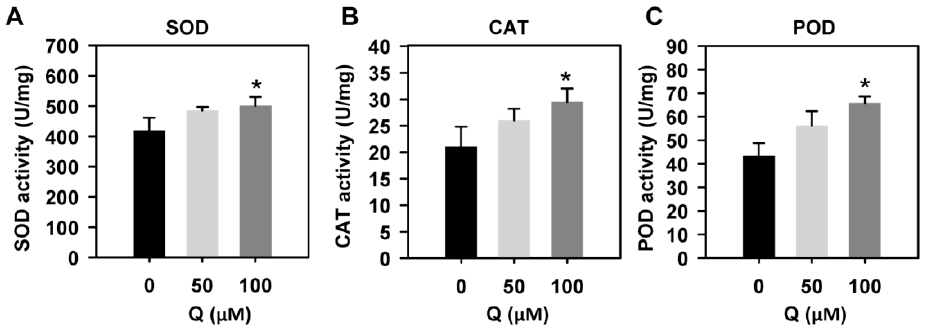
Figure 7. SOD, CAT, and POD activities in rice roots treated with or without quercetin. ( A ) SOD activities in rice roots treated with 0, 50, or 100 µ M of quercetin. ( B ) CAT activities in rice roots treated with 0, 50, or 100 µ M of quercetin. ( C ) POD activities in rice roots treated with 0, 50, or 100 µ M of quercetin. Three-day-old rice seedlings were treated with 0, 50, or 100 µ M of quercetin for another two days. The roots were excised from the seedlings and the total proteins were prepared for the SOD, CAT, and POD assays. The data are presented as means ± SD ( n = 3). Asterisks indicate the significant difference relative to WT (Student’s t -test, * p < 0.05).